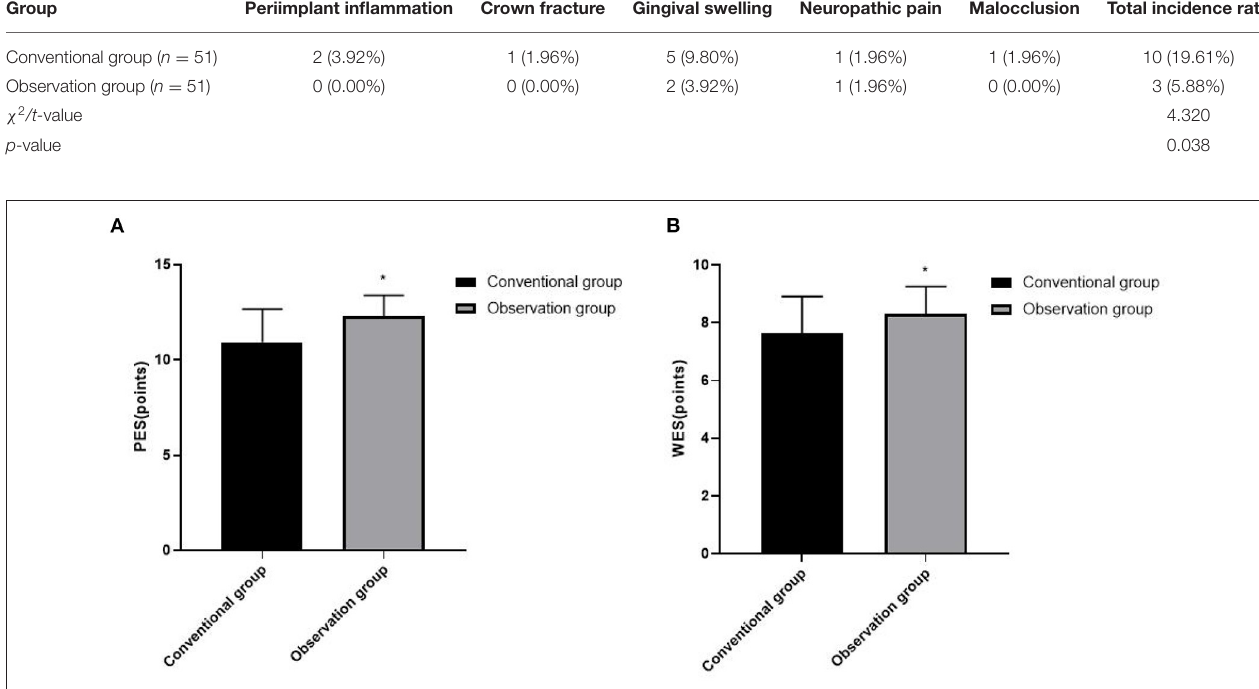
Imaging Department, and the final score was scored by the total average.